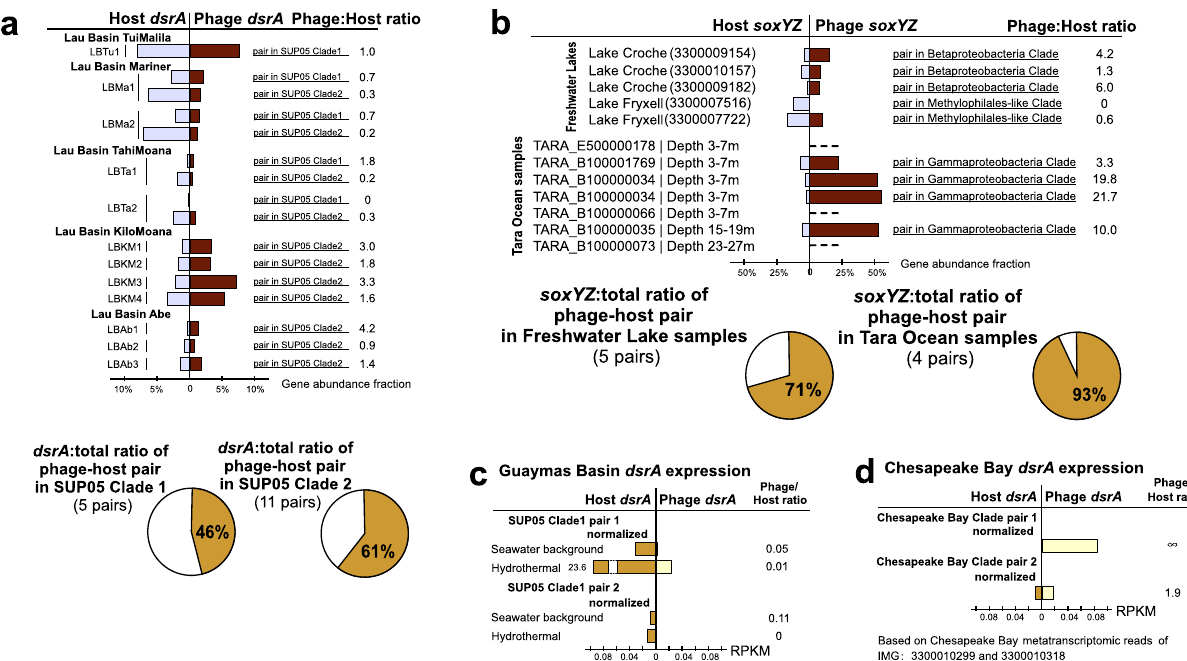
Fig. 7 Phage to host dsrA and SoxYZ gene coverage ratios and dsrA gene expression comparison between phage and host pairs. a Phage dsrA to total gene coverage ratios of each phage-host pair. Average phage dsrA :total ratios of phage-host pairs in SUP05 Clade 1 and Clade 2 were calculated by 5 and 11 pairs of genes, respectively. b Phage soxYZ to total gene coverage ratios of each phage-host pair. The contribution of phage soxYZ genes from three different clades is shown in different colors. Average phage dsrA :total ratios of phage-host pairs in freshwater lakes and Tara Ocean were calculated separately. Tara Ocean sample IDs were labeled and the corresponding metagenome IDs were listed in Supplementary Data 4. c Phage to host dsrA gene expression comparison in Guaymas Basin metatranscriptomes. The same database was used for mapping both hydrothermal and background metatranscriptomic datasets. d Phage to host dsrA gene expression comparison in Chesapeake Bay metatranscriptomes. The same database was used for mapping all Chesapeake Bay metatranscriptomic datasets. Gene expression levels are shown in RPKM normalized by gene sequence depth and